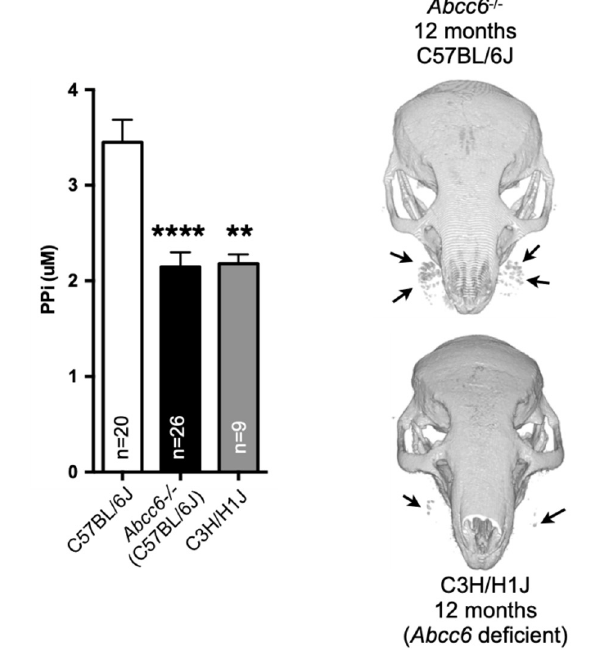
Figure 2. Plasma pyrophosphate levels do not correlate with the calcification phenotype in mice. Plasma pyrophosphate levels in Abcc6 − / − mice (C57BL/6J background), and in C3H/H1J mice with a naturally occurring Abcc6 mutation are virtually identical and significantly lower than wild type C57BL/6J mice. However, at 12 months of age, Abcc6 − / − mice present a much more pronounced vibrissae calcification as shown on this μ CT scan rendering (right, arrows). Plasma PPi results are shown as means +SEM. p -values were determined by Student’s t -test. ** p < 0.01, **** p < 0.0001. Derived from [111].